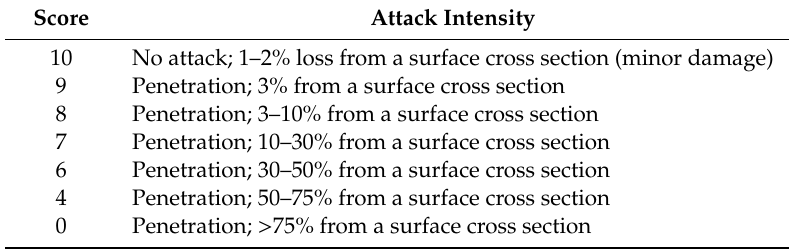
Table 1. Classification of wood damage assessment.